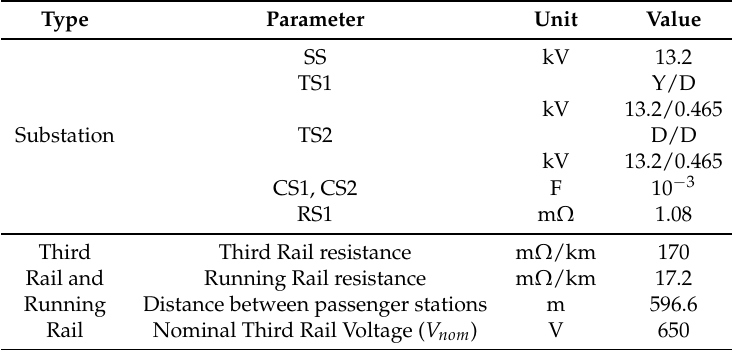
Table A1. System